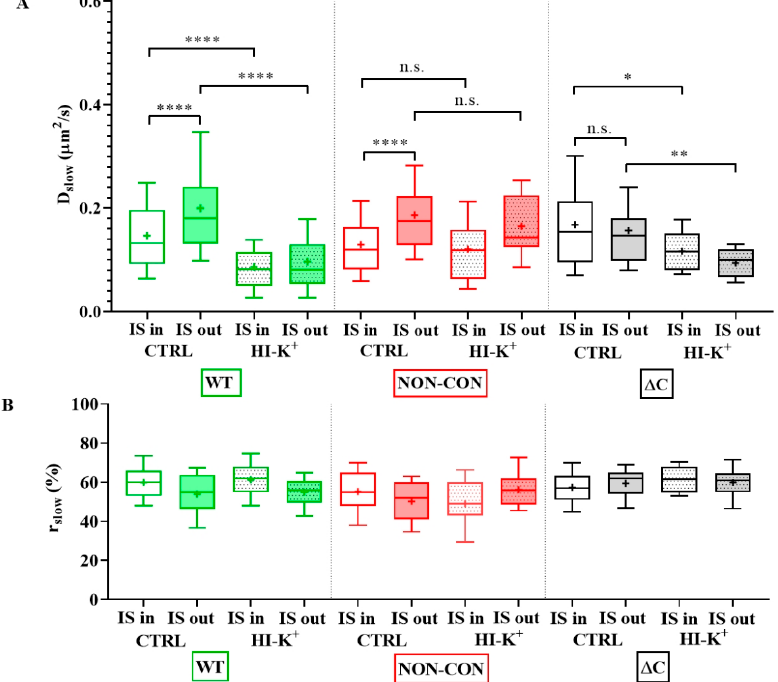
Figure 4. Mobility of wild type and mutant Kv1.3 channels on Jurkat T cells forming immunological synapses with Raji B cells at resting membrane potential and upon depolarization. ( A ) Slow diffusion coefficients of the WT and NON-CON channels decreased significantly inside the IS. However, that of the C-terminally truncated ( Δ C) mutant did not change significantly. We also studied the effect of a depolarizing milieu. The mobility of WT and Δ C channels decreased significantly upon depolarization by high-K + solution both inside and outside the IS. In contrast, the mobility of the NON-CON channels did not show significant alterations. ( B ) Average proportion of the slow dif- fusing component ( r slow ) was not significantly affected by being partitioned in the IS, by mutation, or by depolarization. * p < 0.05, ** p < 0.01, **** p < 0.0001, n.s. not significant. As a further control, we measured the mobility of the IL-2R α receptor subunit in standalone and IS-engaged Jurkat cells expressing WT mGFP-Kv1.3. IL-2 receptors can also be found at the IS and are enriched in lipid raft domains [33,34]. The mobility of IL- 2R α decreased in the IS as compared to that outside the IS (Figure 5). Similar to Δ C chan- nels, IL-2R α was more mobile in standalone cells as compared to IS-engaged cells, con- trary to Kv1.3 possessing an intact C-terminus.